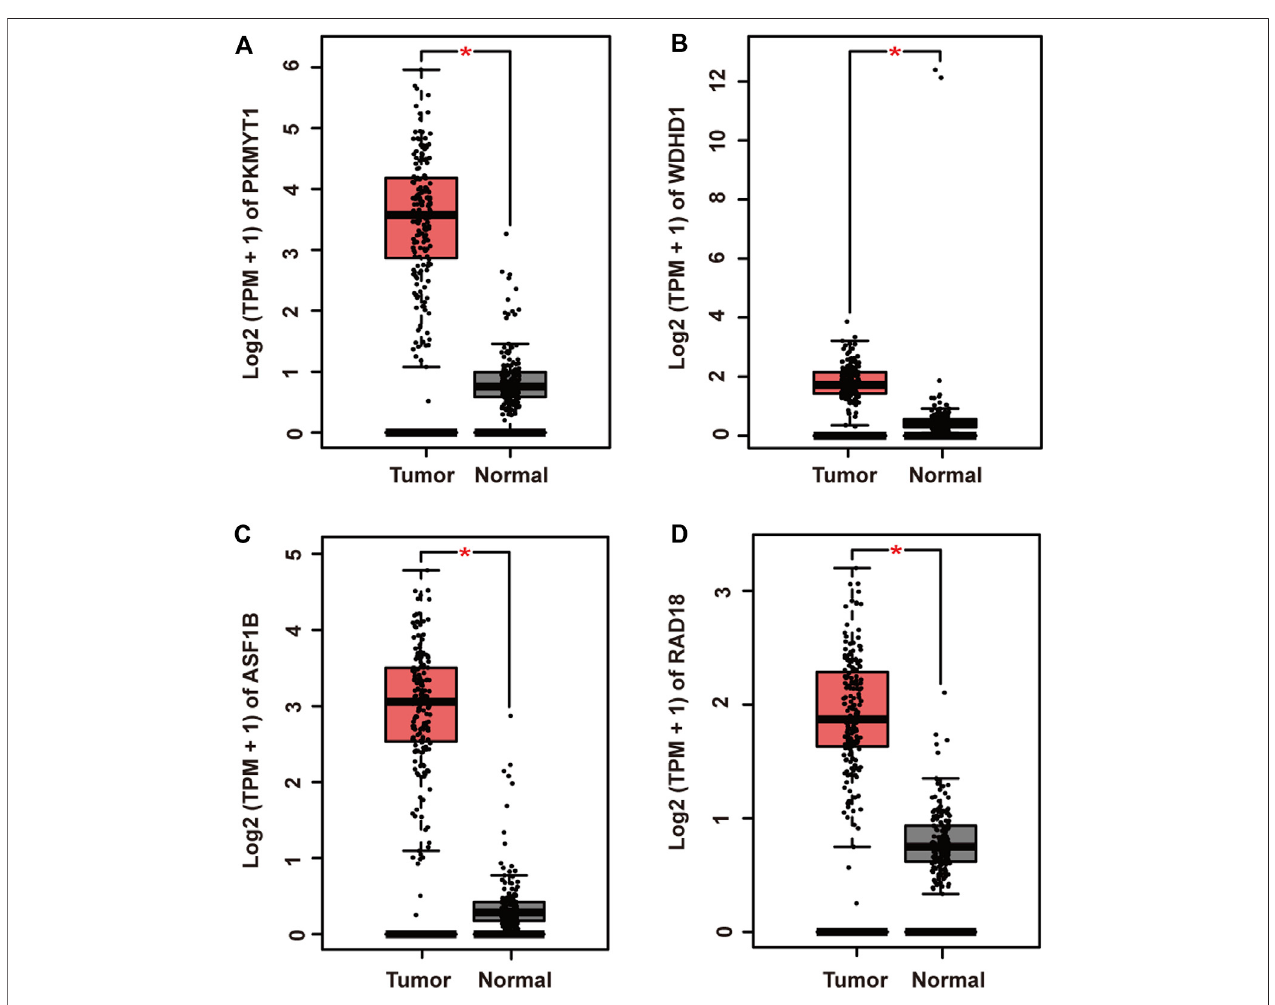
FIGURE 3 | Relative mRNA expression of four hub genes in pancreatic adenocarcinoma and adjacent normal tissues from TCGA. (A) PKMYT1. (B) WDHD1. (C) ASF1B. (D) RAD18. The expressions of these genes were signi fi cantly up-regulated in tumor samples.